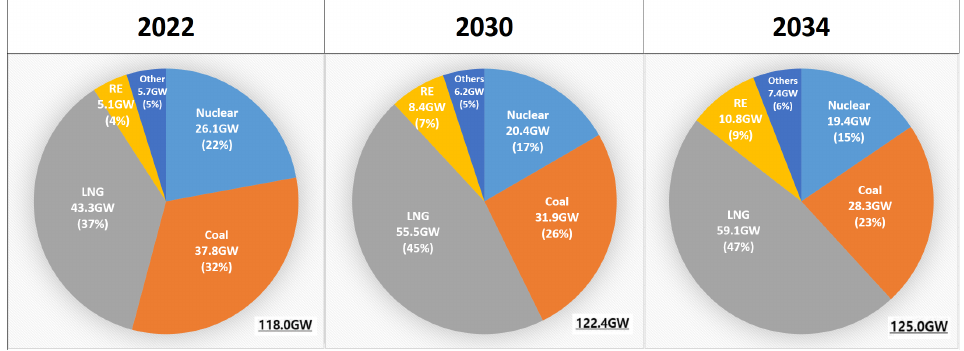
Figure 2. Planned effective capacity by year according to the 9th Basic Plan.